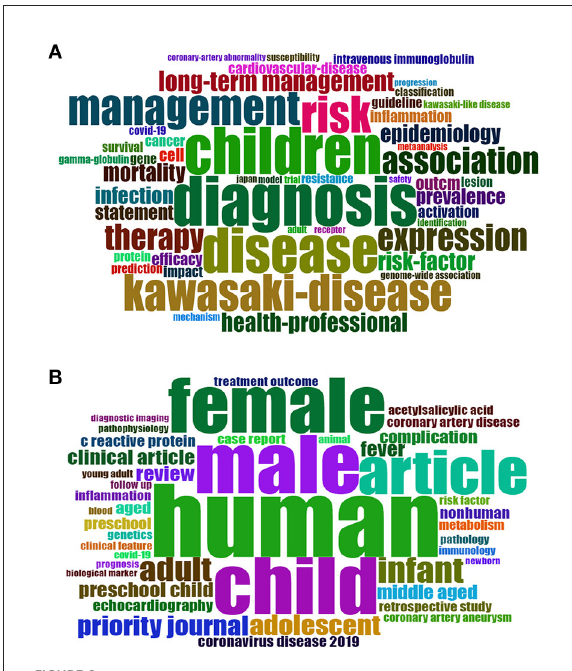
FIGURE6 Visualized word-clouds of keywords plus in WOS (A) and Scopus (B) (Only show the first 50